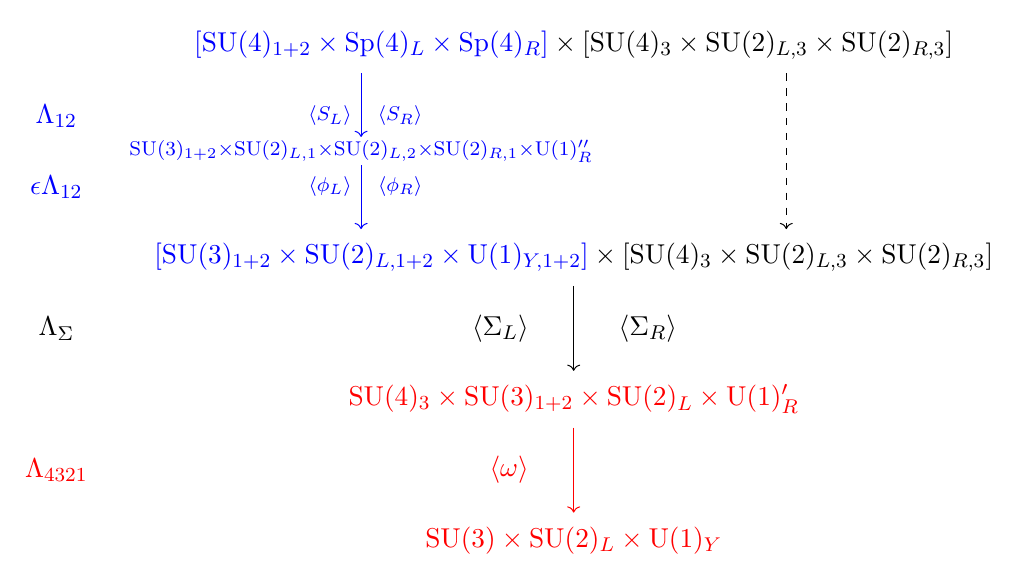
Figure 1 . The symmetry breaking scheme in our model. The portion of the diagram coloured blue is responsible for generating the light family Yukawas, and thus for controlling the flavour structure of the light family sector. The portion coloured red mimics the low-energy breaking of so-called ‘4321 models’, delivering in particular a U leptoquark coupled mostly to the third family. We will 1 eventually suggest concrete scales for each Λ that appears on the vertical ‘axis’ — see figure